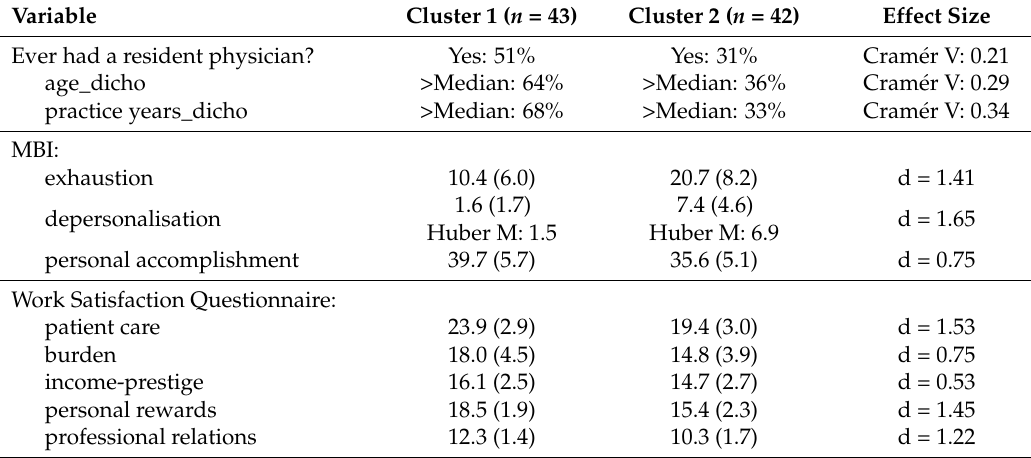
Table 3. Descriptive statistics of classification variables in Clusters 1 and 2, and effect sizes of differences between the two